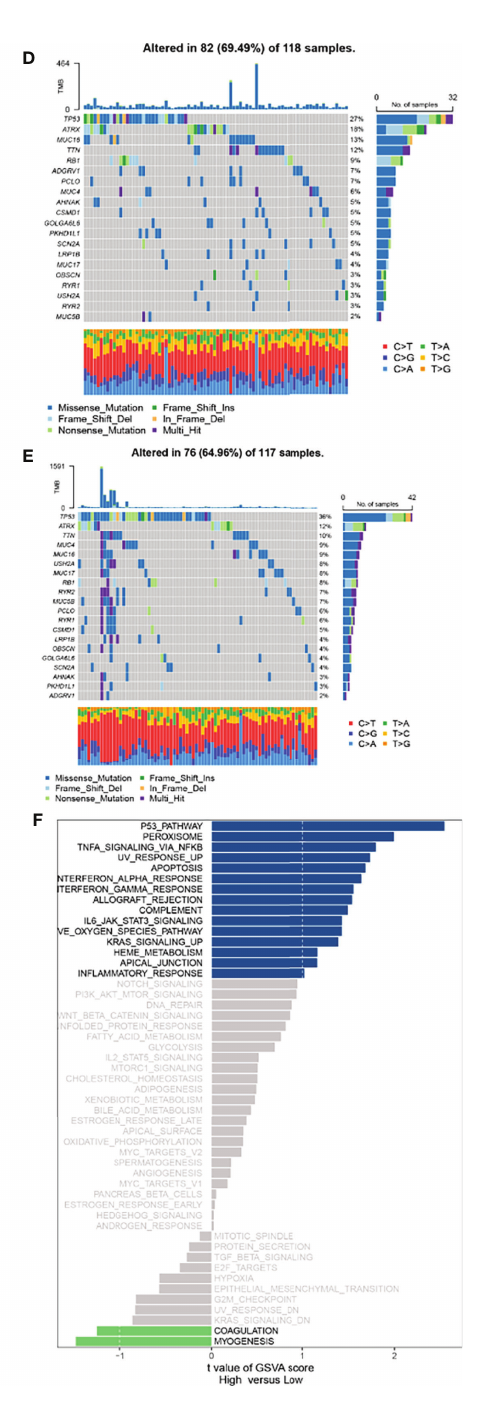
FIGURE 9 | Potential role of risk score in mutation and immunotherapy. (A) The proportion of clinical response to anti-PD-1 with anti-CTLA-4 immunotherapy in two risk groups in the melanoma cohort. (B) The progression-free survival (PFS) curve comparing survival of two risk groups in a cohort of melanoma patients treated with combination of anti-PD-1 and anti-CTLA-4. (C) The frequency of arm-level ampli fi cation and deletion between two risk groups. (D, E) The somatic mutation frequency of two risk groups in TCGA-SARC cohort. (F) Differences in pathway activities between two risk groups. *p < 0.05; ns, p ≥